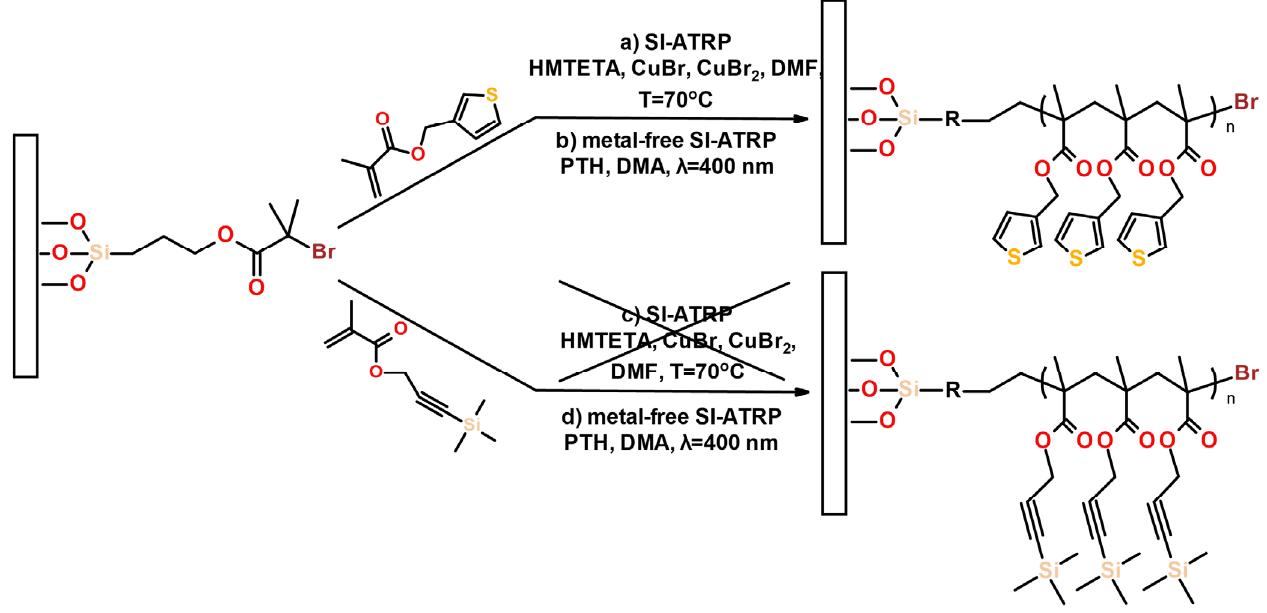
Figure 1. Scheme of a synthesis of PMTM and PTPM brushes via copper-based SI-ATRP and metal-free SI-ATRP.